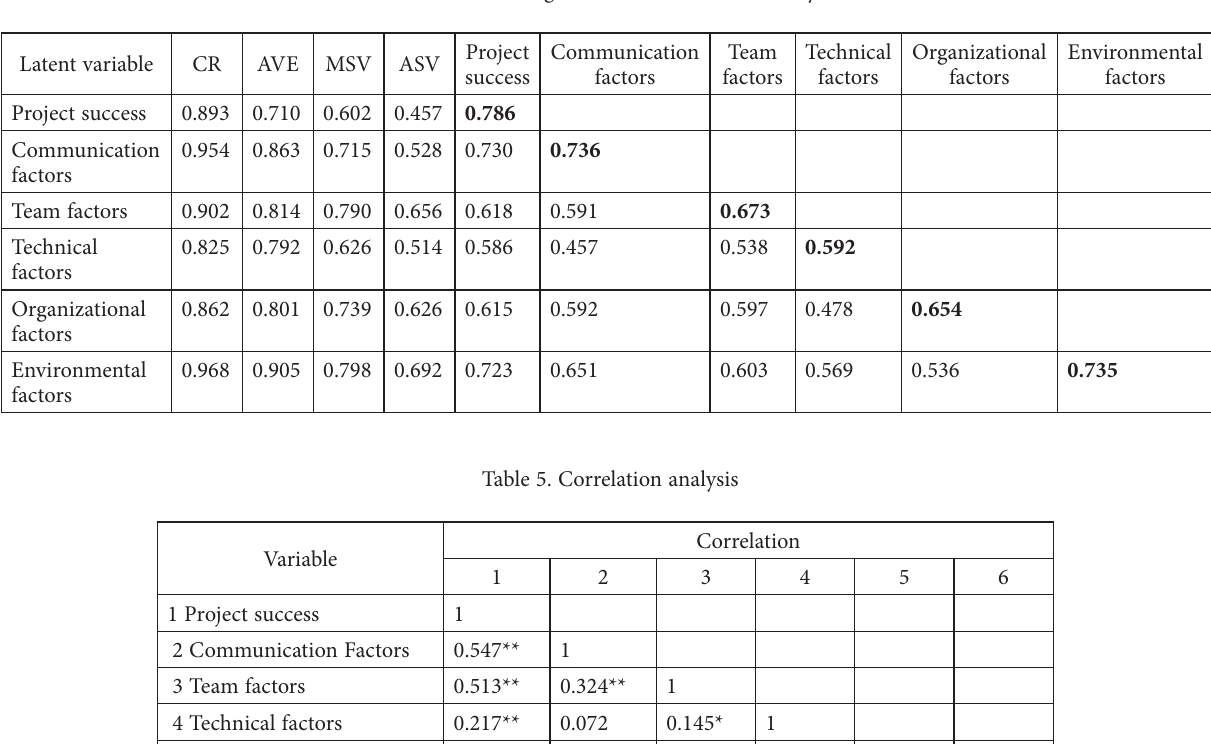
Table 4. Convergent and discriminant validity